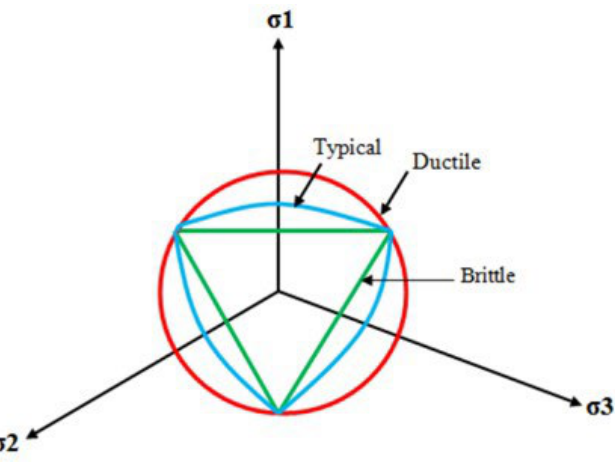
Figure 5- Deviatoric cross section of a strength